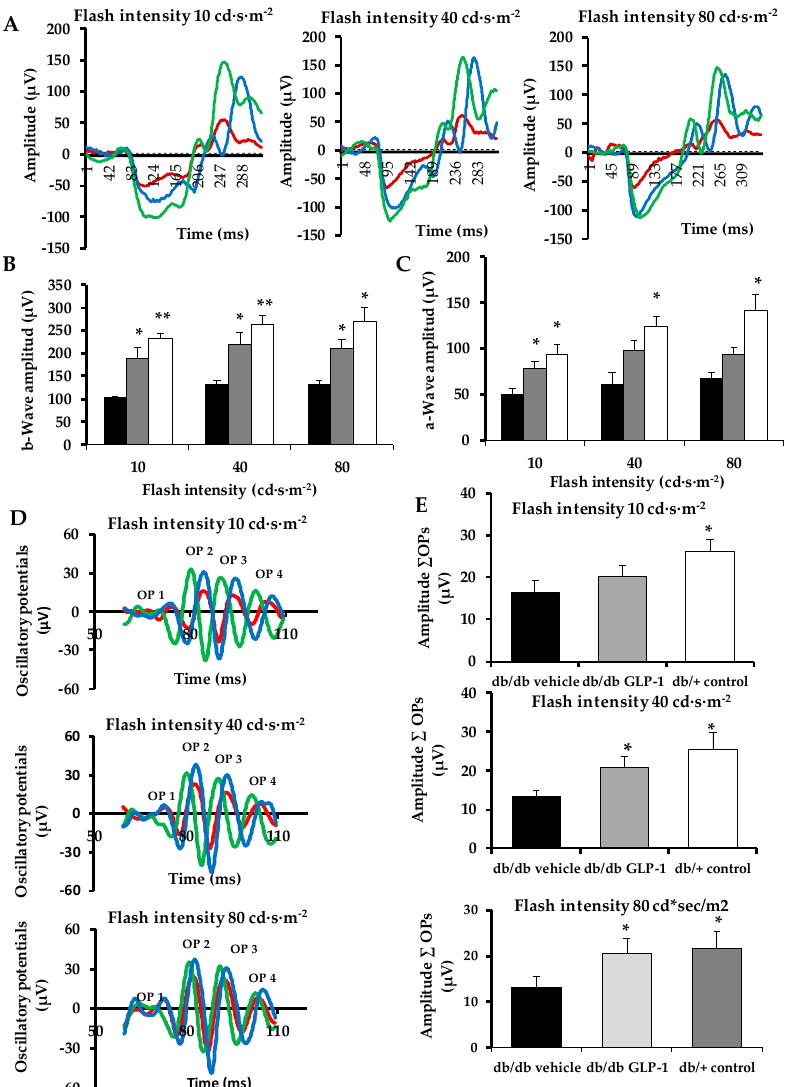
Figure 1. Electroretinogram. ( A ) Electroretinogram traces in response to low, medium and high stimulus intensities (10 cd · s · m − 2 , 40 cd · s · m − 2 and 80 cd · s · m − 2 ) in a representative non-diabetic mouse (green), a db/db mouse treated with vehicle (red) and a db/db mouse treated with glucagon-like peptide-1 (GLP-1) eye-drops (blue); ( B ) Quantitative analyses of b-wave amplitude in db/db mice treated with vehicle (black bars), db/db mice treated with GLP-1 eye drops (grey bars) and non-diabetic mice (white bars). ( n = 4 mice per group) * p < 0.05 in comparison with db/db vehicle; ** p < 0.01 in comparison with db/db vehicle. ( C ) Quantitative analyses of a-wave amplitude in db/db mice treated with vehicle (black bars), db/db mice treated with GLP-1 eye drops (grey bars) and non-diabetic mice (white bars). ( n = 4 mice per group) * p < 0.05 in comparison with db/db vehicle; ( D ) Oscillatory potential traces in response to low, medium and high stimulus intensities (10 cd · s · m − 2 , 40 cd · s · m − 2 and 80 cd · s · m − 2 ) in a representative non-diabetic mouse (green), a db/db mouse treated with vehicle (red) and a db/db mouse treated with GLP-1 eye-drops (blue); ( E ) Quantitative analyses of oscillatory potentials at 10 cd · s · m − 2 , 40 cd · s · m − 2 and 80 cd · s · m − 2 in db/db mice treated with vehicle (black bars), db/db mice treated with GLP-1 eye drops (grey bars) and non-diabetic mice (white bars). ( n = 4 mice per group) * p < 0.05 in comparison with db/db vehicle.